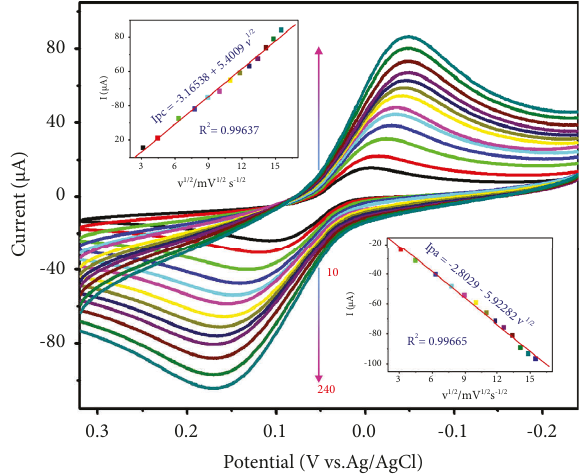
Figure 8: Cyclic voltammograms at Cu/rGO/GCE in 0.1 M PBS (pH 6.5) containing 5.0 μ M HQ with different scan rates of 10, 20, 40, 60, 80, 100, 120, 150, 180, 200, 220, and 240 mV · s − 1 , respec- tively. Plots of peak currents vs. the square root of scan rates for HQ